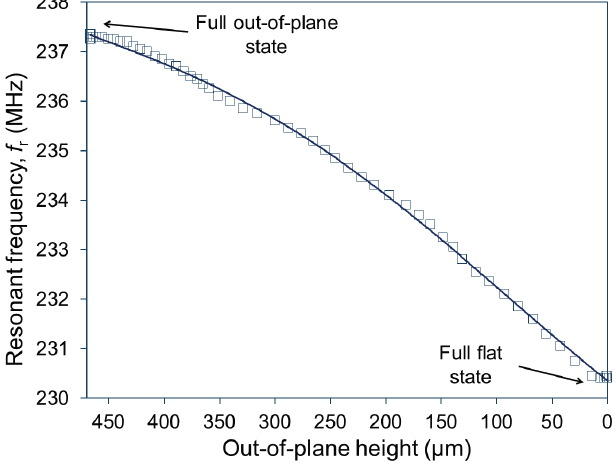
Figure 5. Wirelessly detected f vs. out-of-plane height of the SMA actuator varied by RF r excitation at f = 231 m